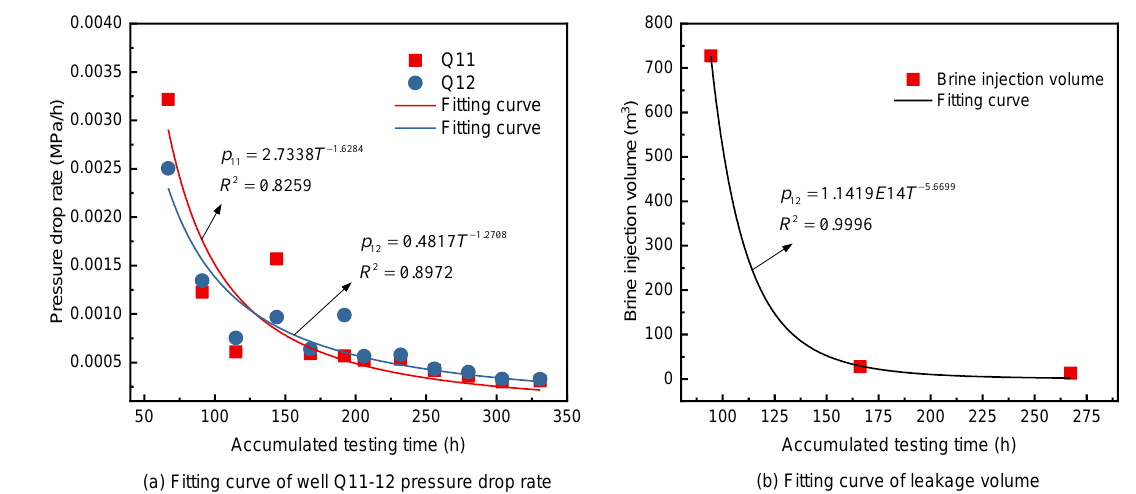
Figure 14. Fitting curve of Brine Injection Test data.